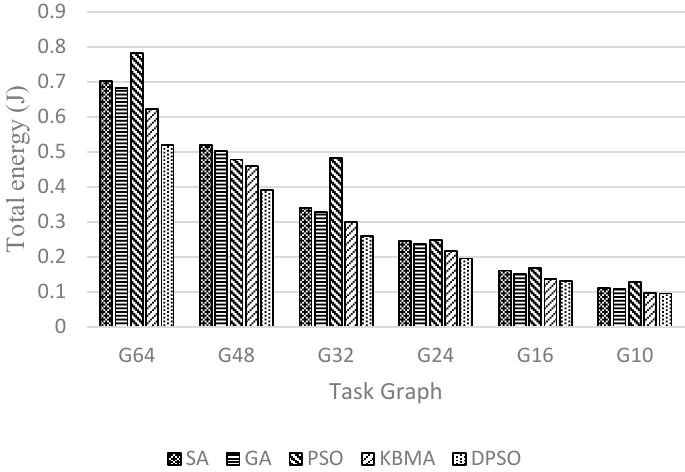
× 4 × 4 3D mesh Figure 9. Energy loss at different sizes of random task graphs on 4 × 4 × 4 3D mesh structure. Figure 9. Energy loss at different sizes of random task graphs on 4 Figure 9. Energy loss at different sizes of random task graphs on 4 × 4 × 4 3D mesh structure. Figure 9. Energy loss at different sizes of random task graphs on 4 × 4 × 4 3D mesh structure.